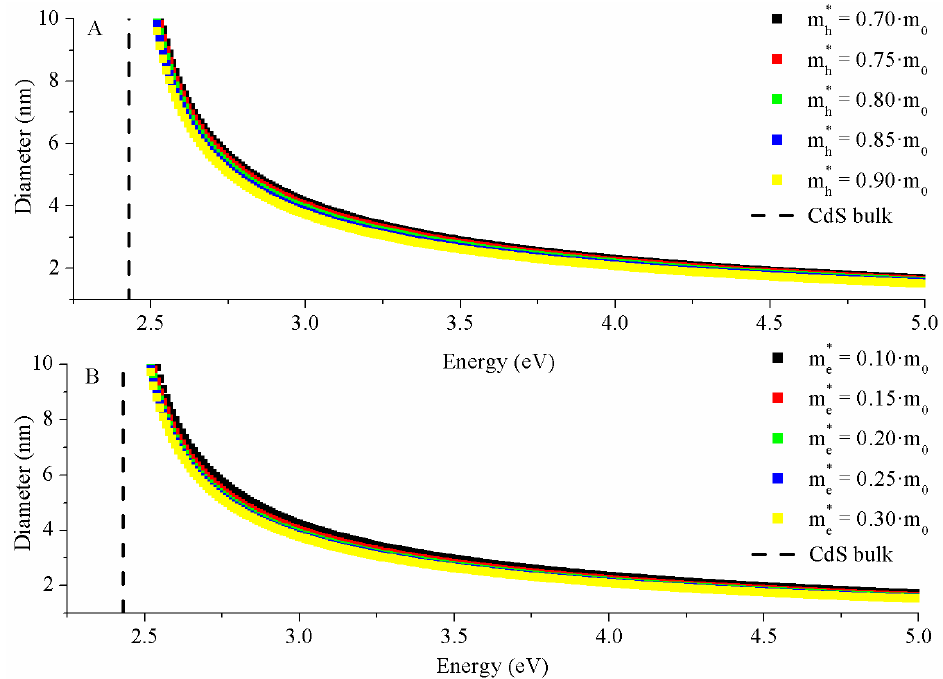
Figure 9. Estimated CdS NPs’ size by the hyperbolic band model (HBM) model as a function of nanoparticle bandgap energy with ( A ) m h * and m e * ( B ) as parameters. The m h * oscillated between m h * = 0.70 · m o and m h * = 0.90 · m o and m e * oscillated between m e * = 0.10 · m o and m h * = 0.30 · m o , with E b remaining constant, E b = 2.42 eV.